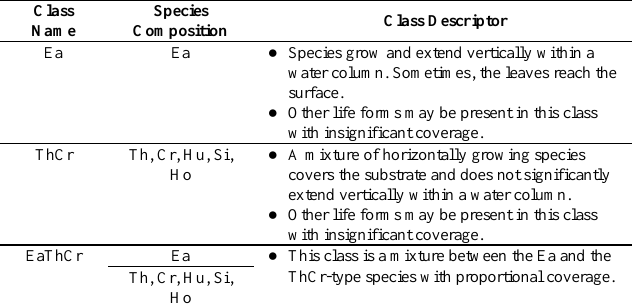
Table 1. The classification scheme for seagrass species composition based on life forms (Wicaksono, Hafizt, 2013).